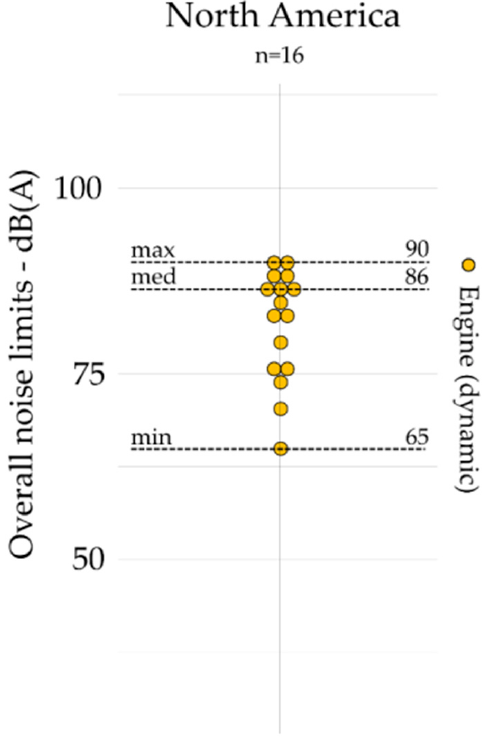
Figure 1. Overall indicators for emission scope (i.e., engine) identified in North America ( n = 16).